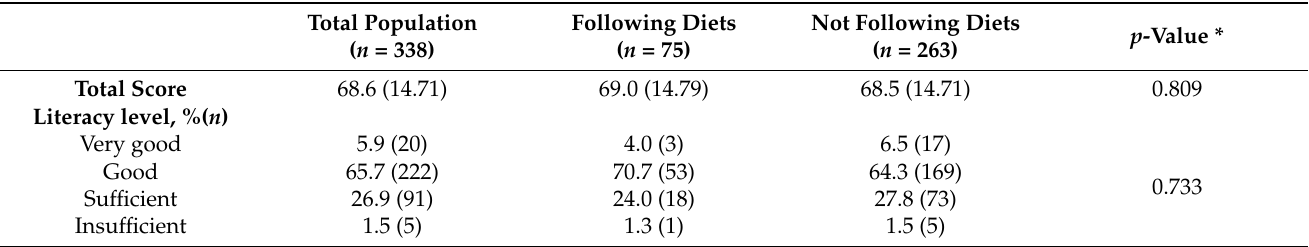
Table 8. The literacy level of the population studied according to following or not specific dietary patterns. Total